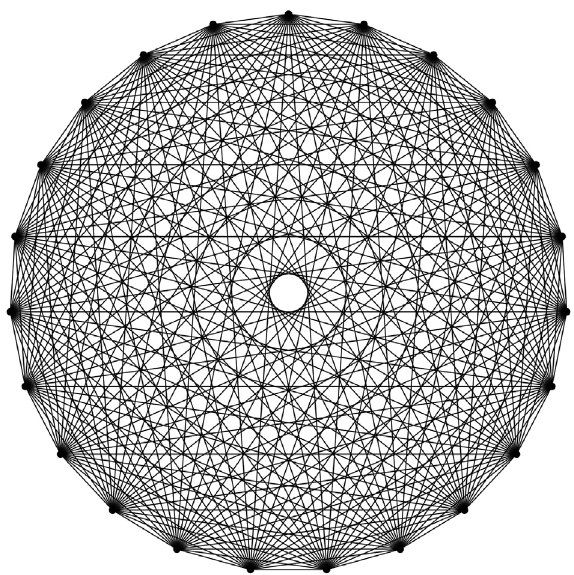
Figure 18. Connecting equally spaced points on a circle (the circle itself is not shown, only connections; when m is even, connections pass through the center).